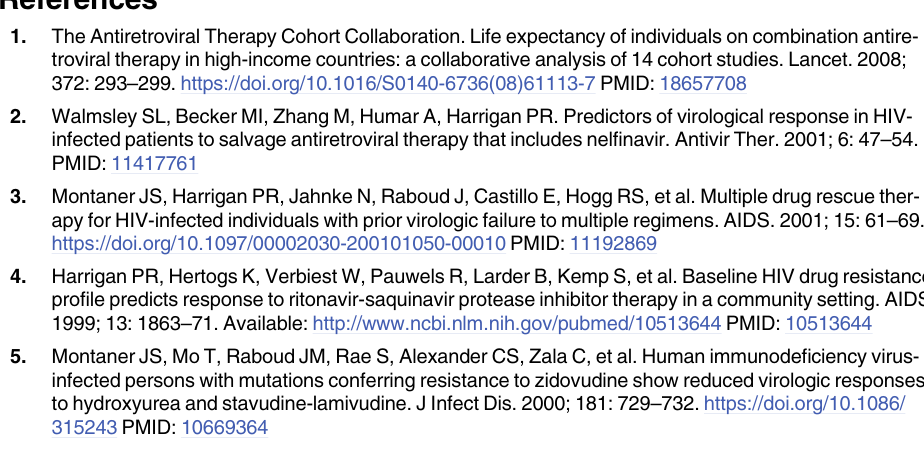
S7 Table. Access to drug resistance testing cohort; comprehensive univariable and multi- variable models using GEE logistic regression. S8 Table. Development of drug resistance cohort; comprehensive univariable and multi- variable models using Cox proportional hazards